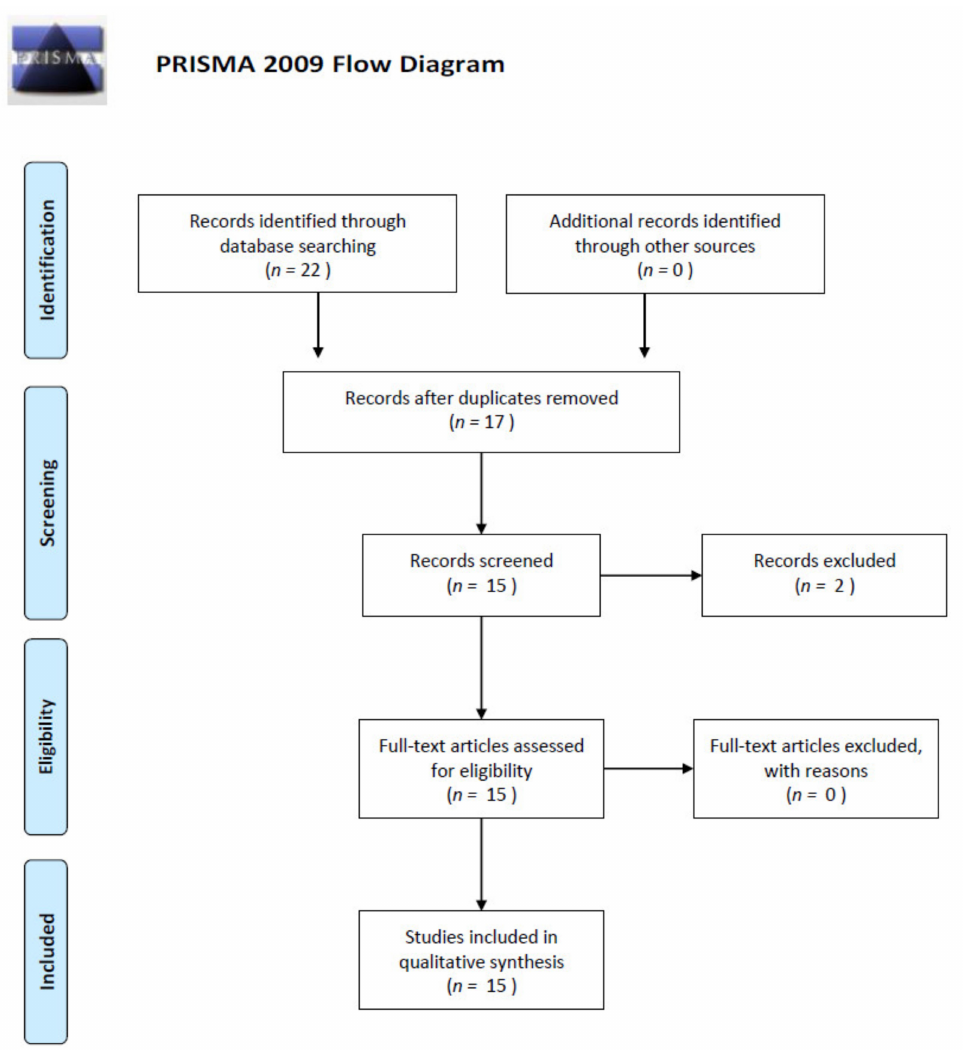
Figure 5. Schematic illustration of articles included in the